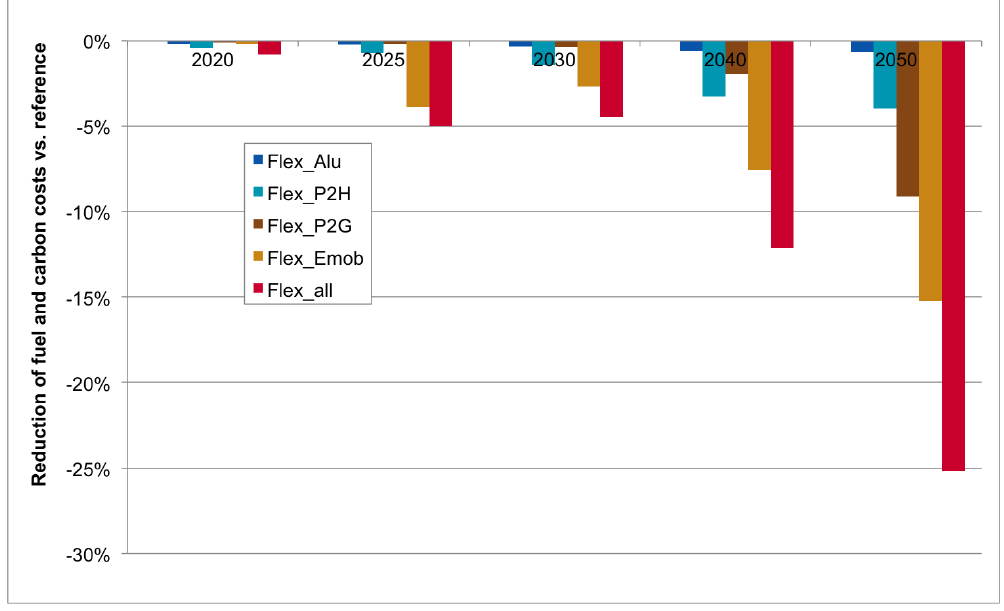
Figure 4. Reduction of operating